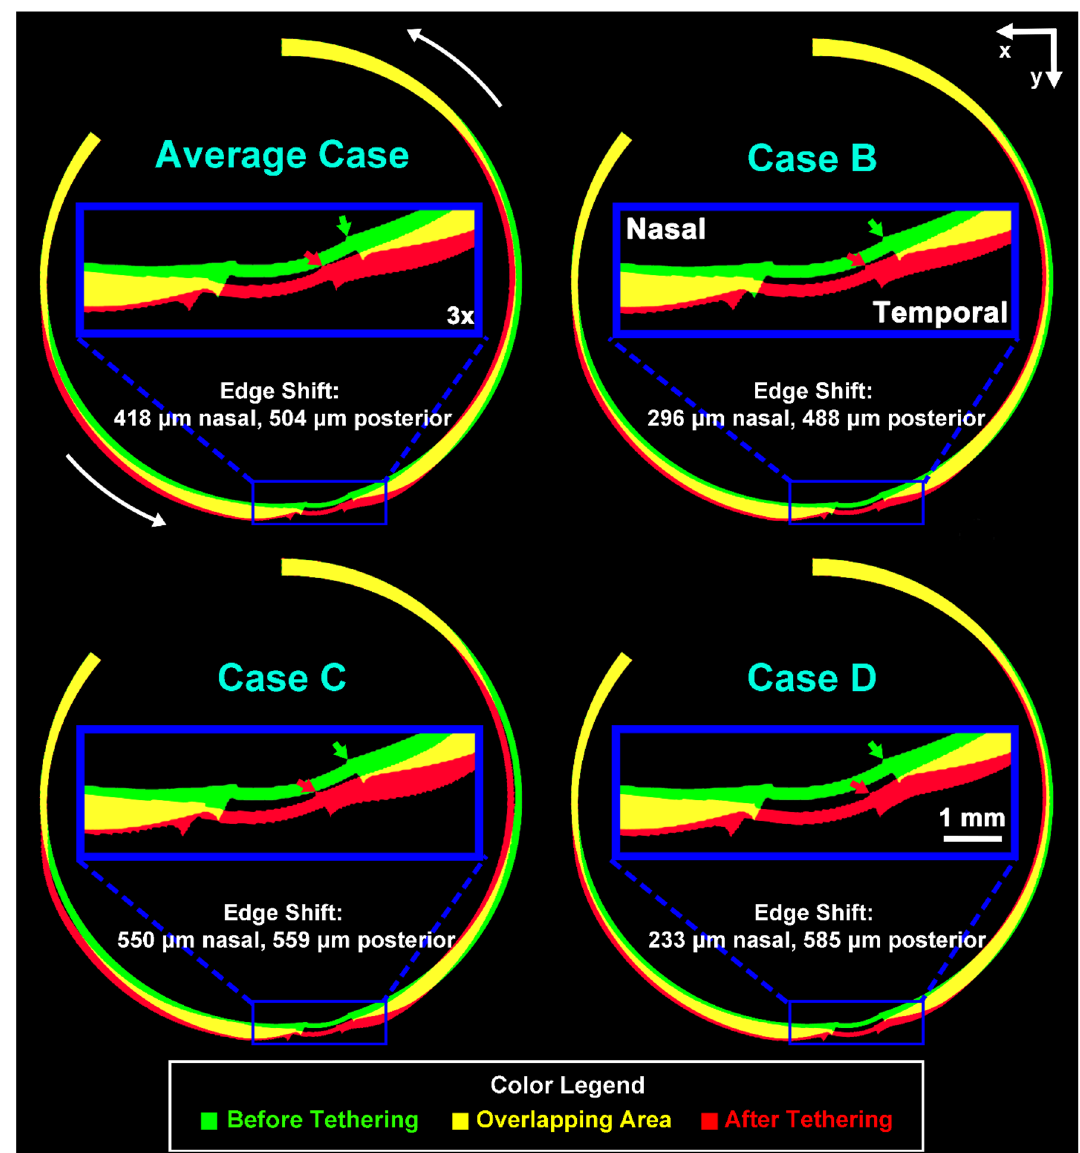
Figure 3. Horizontal cross sections of finite element model superimposing initial configuration of 26° adduction at initiation of tethering (green) with final configuration of 32° adduction (red) for various combinations of observed tissue properties as defined in Fig. 2. Yellow region represents overlap. Blue inset shows 3 × magnified view of the optic disc region where arrows indicate locations of temporal edge of the lamina cribrosa, whose displacements are listed numerically for each